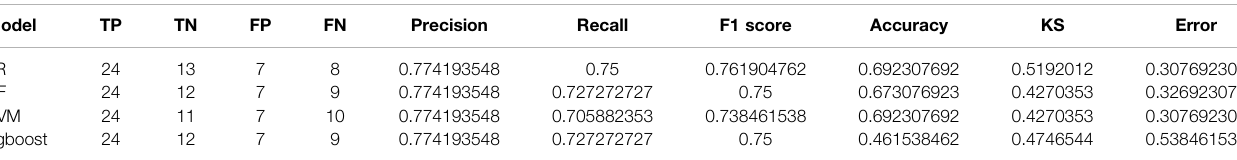
TABLE 2 | Comparison of the diagnostic ef fi cacy of four different machine learning models.